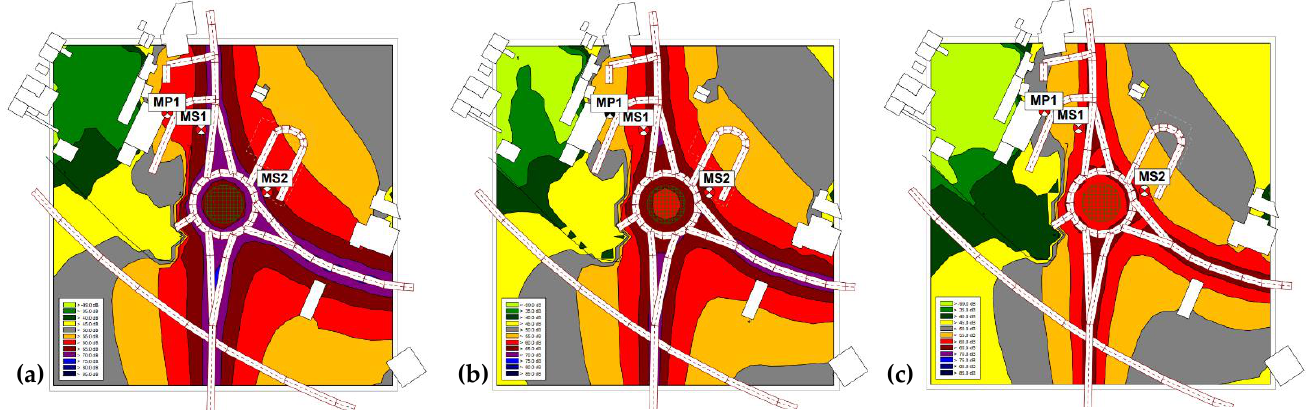
Figure 10. Model of the spreading of noise emissions from road traffic in the vicinity of the new roundabout in the city of Žilina (R_17) during the ( a ) daytime, ( b ) evening and ( c ) night-time.